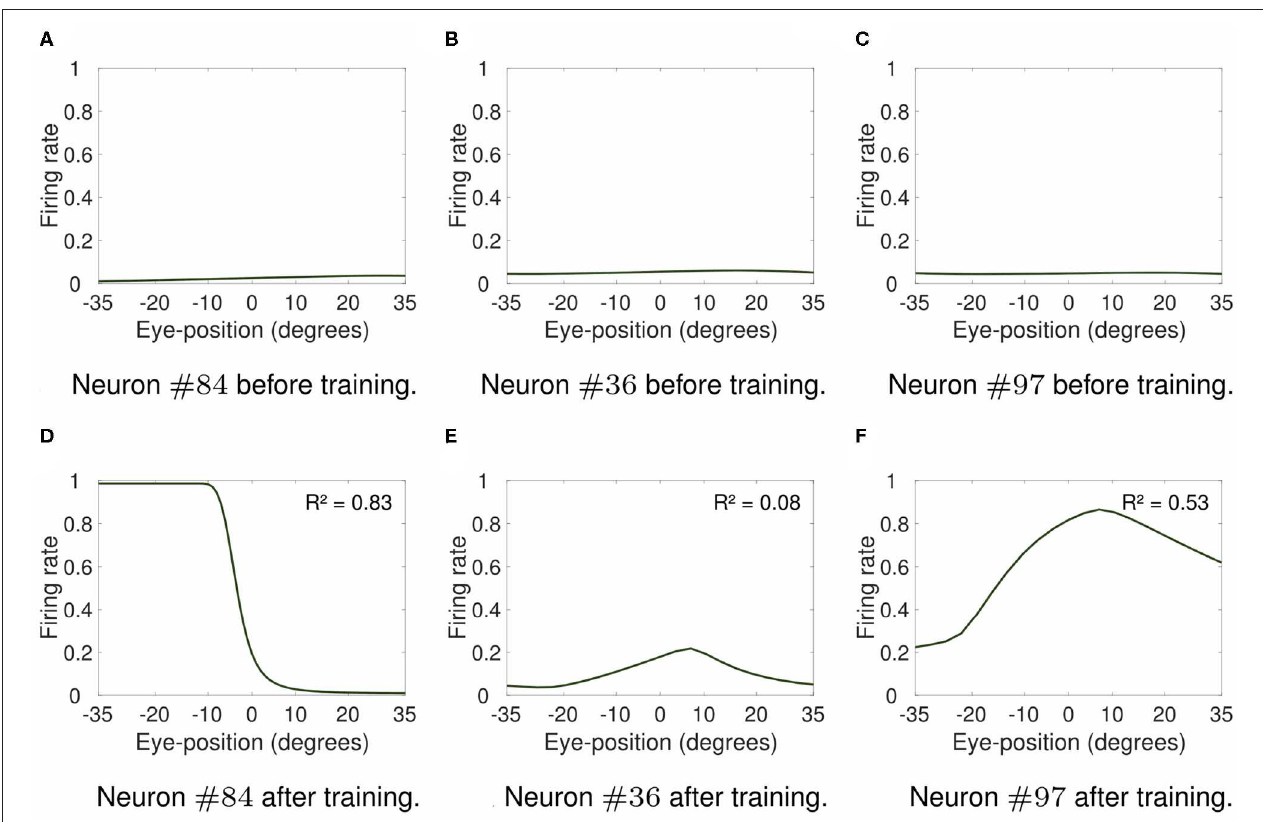
FIGURE 6 | Firing rate responses of output visual neurons in the self-organizing model. Each subplot shows the firing rate responses of output neurons # 84, # 36, and # 97 in the self-organizing model either before training (top row) or after training (bottom row). The responses are plotted for the preferred retinal locations of neurons # 84, # 36, and # 97 at − 10, 0, and 2 ◦ , respectively. These neurons were chosen to show the variety of different forms of visual output responses in the trained model. Table 2 shows the simulation parameters for the model. The value of ρ was set to 15. The comparison of responses prior to training (A–C) to the respective responses after training (D–F) shows that training changed the responses of these output neurons. Particularly, the response curves of neurons # 84, # 36, and # 97 in the trained model (bottom row) resemble the response curves shown in Figure 2 of neurons # 1 ( Figure 2A ), # 475 ( Figure 2C ), and # 1117 ( Figure 2D ) in the hardwired model, respectively. The values of the coefficient of determination R 2 for each response curve in the trained model show that the form of visual responses in the output layer after training varied from non-linear (e.g., R 2 = 0.08 for neuron # 36) to more linear responses (e.g., R 2 = 0.53 and R 2 = 0.83 for neurons # 97 and # 84, respectively). These simulation results show that the use of more biologically realistic Gaussian functions to model the response profiles of input neurons encoding either eye position or retinal location of the visual stimulus enables the self-organizing model to develop a variety of forms of visual responses, including peaked and monotonic, similar to cortical